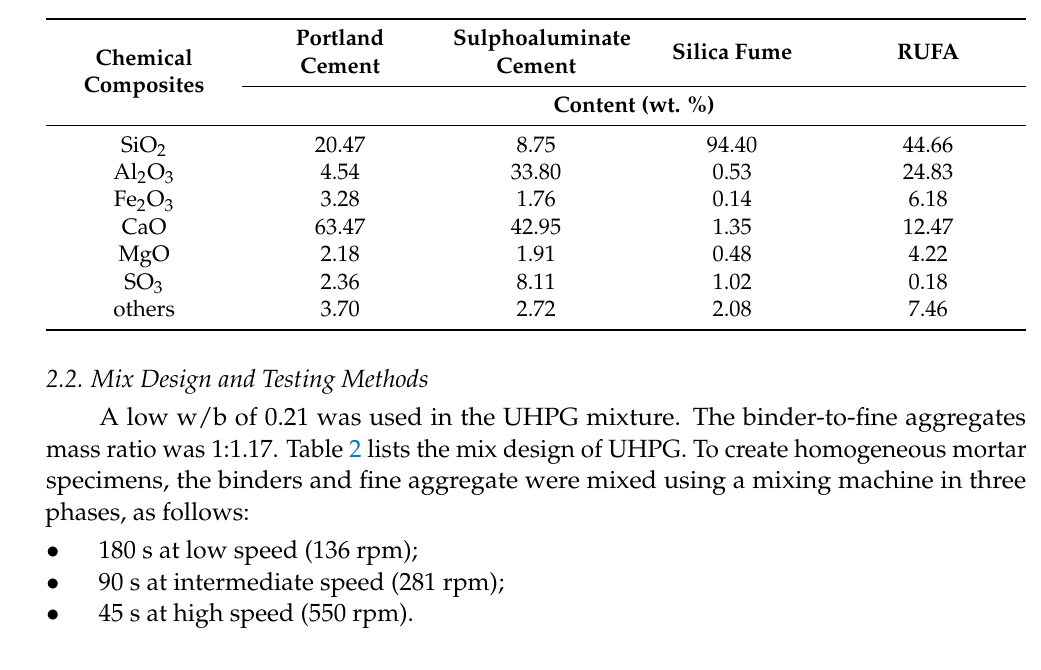
Table 1. The chemical composition of Portland cement, sulphoaluminate cement, silica fume, and RUFA.